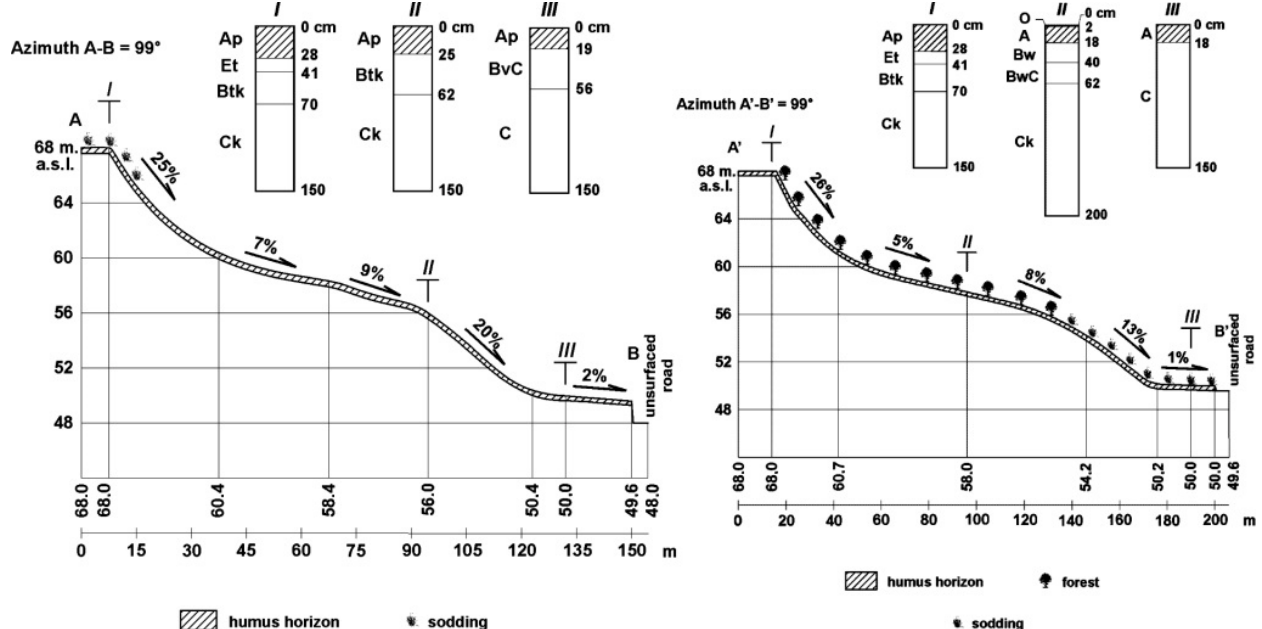
Figure 1. The soil cross sections A-B and A’-B’. Slope gradient in %; A: humus horizon; E: eluvial horizon; B: enrichment horizon; C: parent material (substratum); O: organic horizon; p : plow layer; t (for E horizons): leaching of clay fraction; t (for B horizons): illuvial accumulation of clay; k: accumulation of pedogenic carbonates; v: occurrence of plinthite; w: development of color or structure in a horizon but with little or no apparent illuvial accumulation of materials [39].